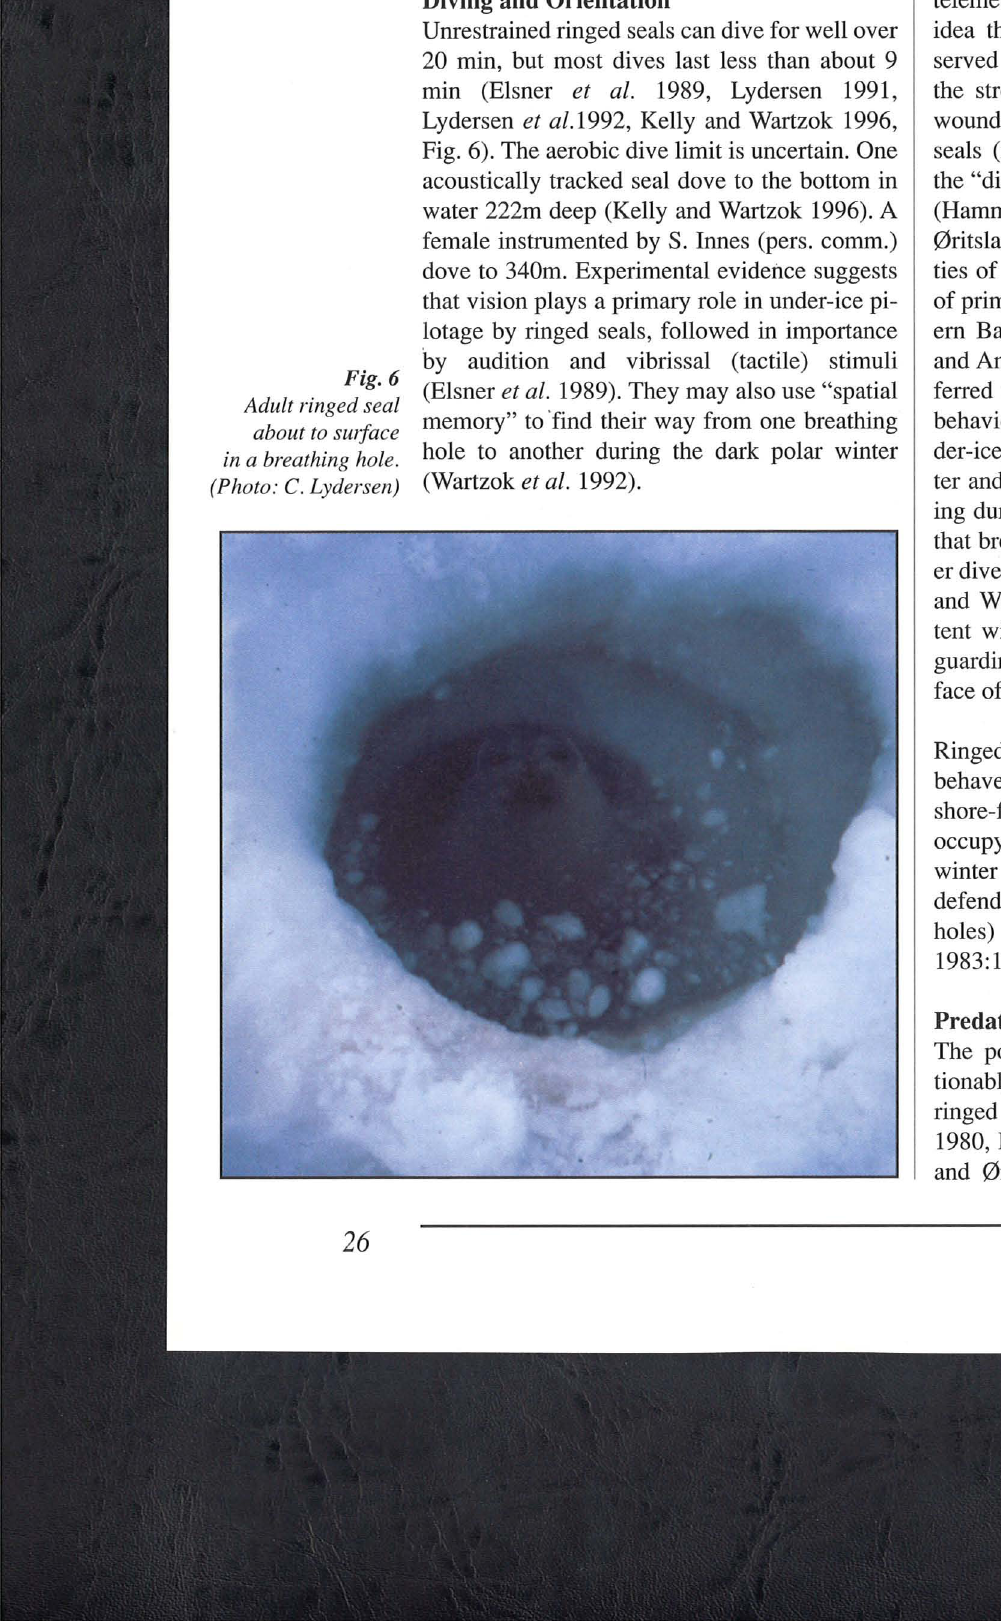
Adult ringed seal about to sUlface in a breathing